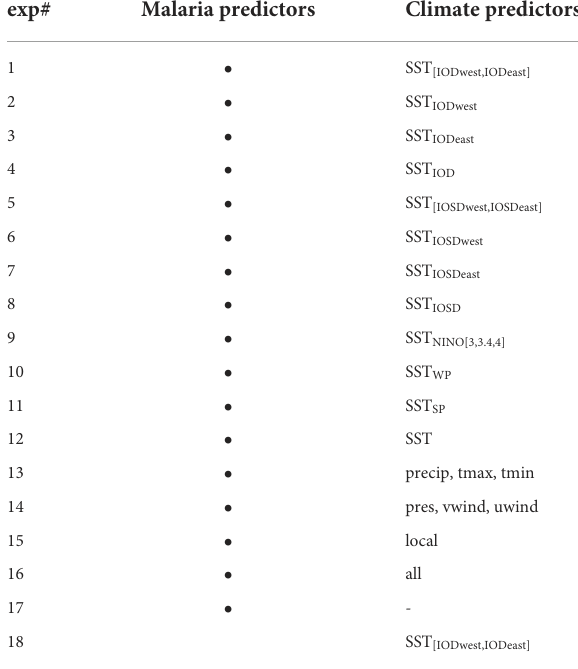
TABLE 3 List of experimental